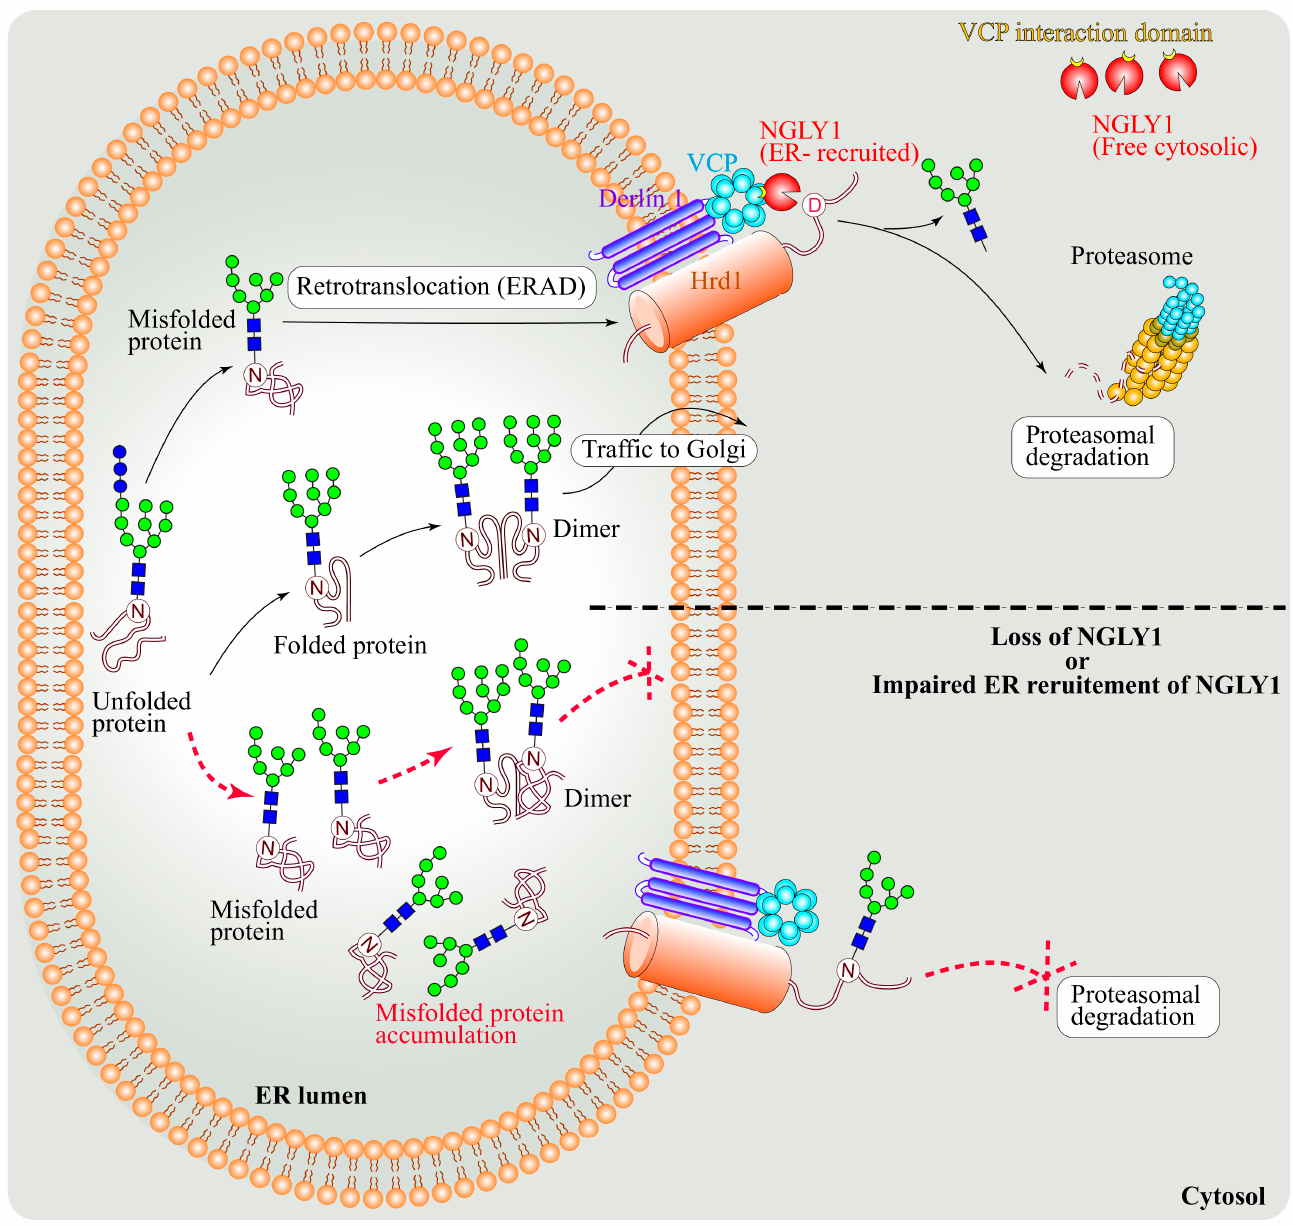
Figure 6. Schematic representation showing that de- N -glycosylation of misfolded bone morphoge- netic protein 4 (BMP4) by endoplasmic reticulum (ER) membrane-recruited NGLY1 promotes its retrotranslocation from ER to cytosol, where it undergoes proteasomal degradation. In the absence of NGLY1 or its impaired ER recruitment, misfolded BMP4 molecules cannot be retrotranslocated to the cytosol and are accumulated in the ER lumen, where they can potentially dimerize with properly folded BMP4 molecules and prevent the trafficking of BMP4 dimers from ER to the Golgi. N, asparagine; D, aspartic acid; VCP, Valosin-Containing protein; ERAD, Endoplasmic reticulum associated degradation.